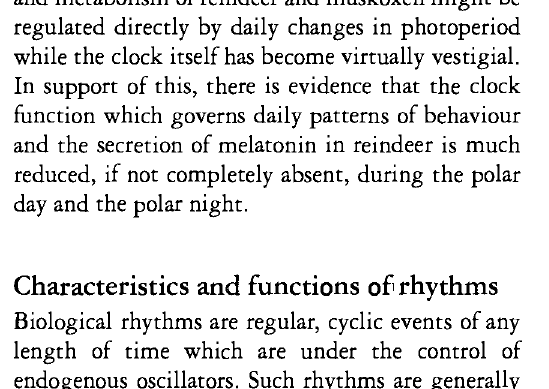
Aug Sep Oct Nov Dec Comparison of daylength at different latitudes. Note both the long period of continuous light and darkness at 80°N and also the much higher speed of changes here in daylength in spring and autumn compared to more southerly